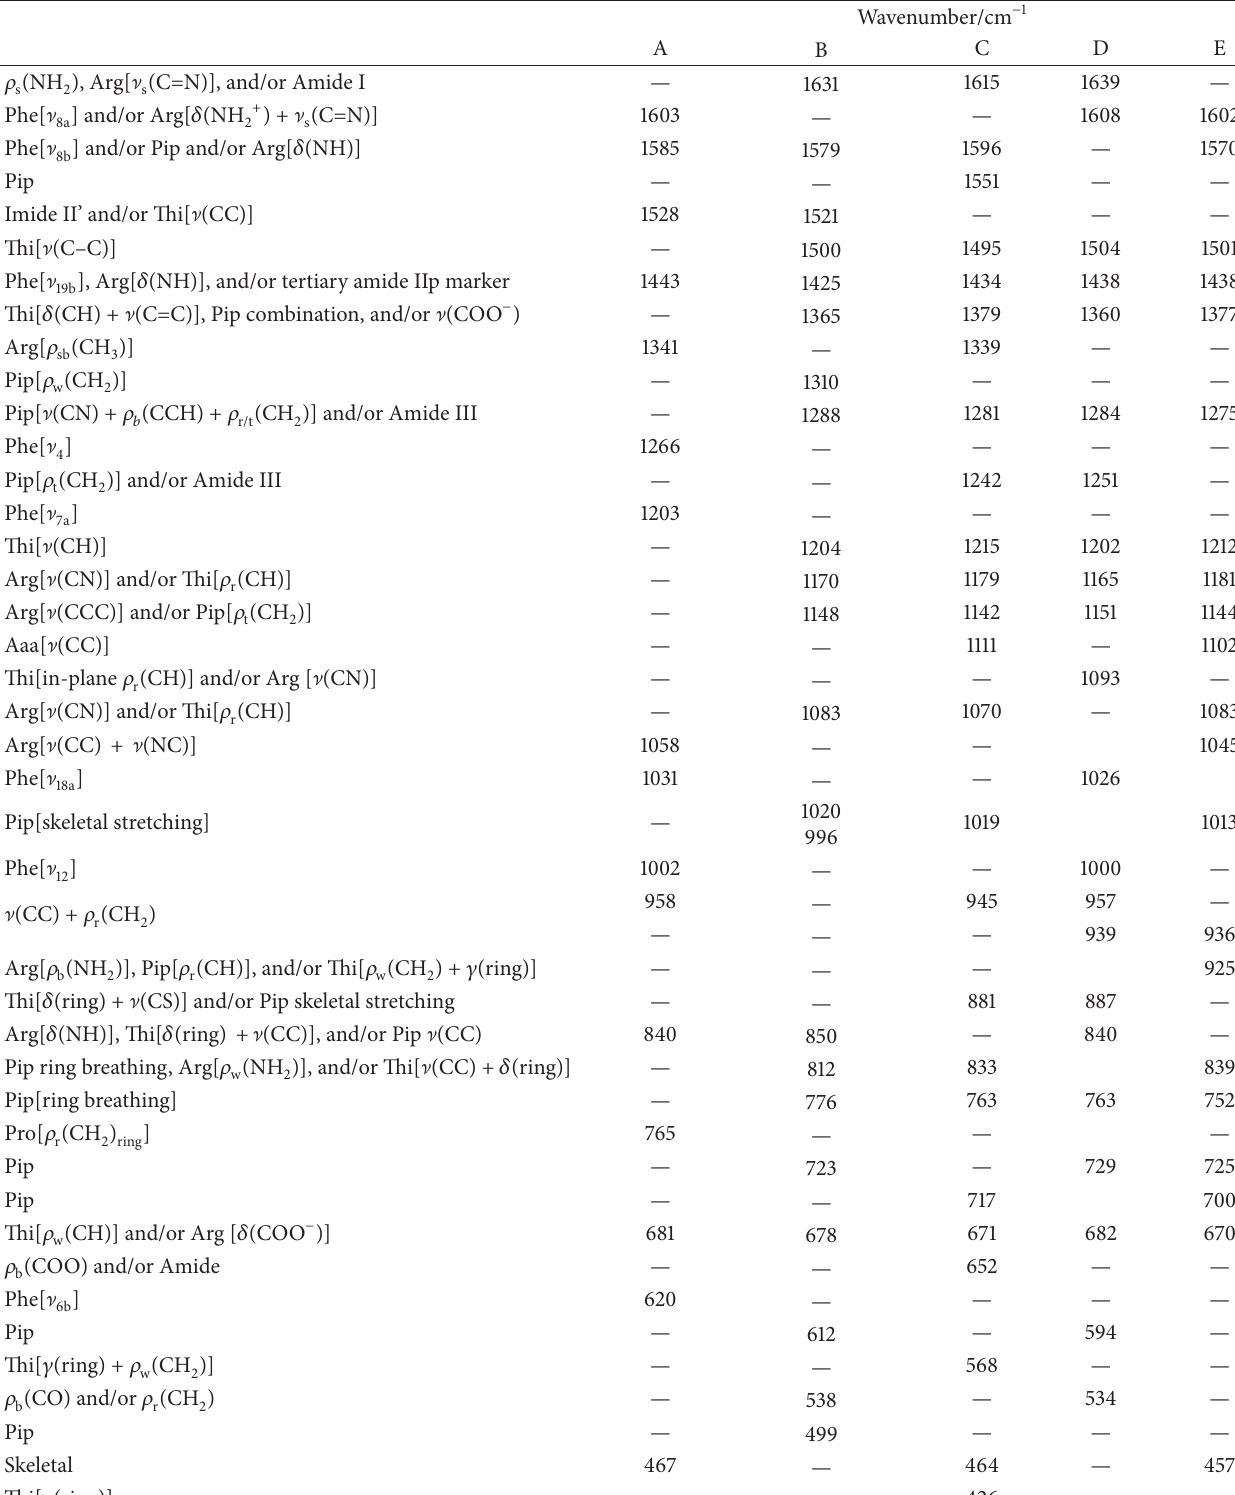
Table 2: Wavenumbers and proposed band assignments for SERS spectra of A: BK, B: [D-Arg 0 ,Hyp 3 ,Thi 5,8 ,L-Pip 7 ]BK, C: Aaa[D- Arg 0 ,Hyp 3 ,Thi 5,8 ,L-Pip 7 ]BK, D: [D-Arg 0 ,Hyp 3 ,Thi 5 ,D-Phe 7 ,L-Pip 8 ]BK, and E: Aaa[D-Arg 0 ,Hyp 3 ,Thi 5 ,D-Phe 7 ,L-Pip 8 ]BK adsorbed onto colloidal gold